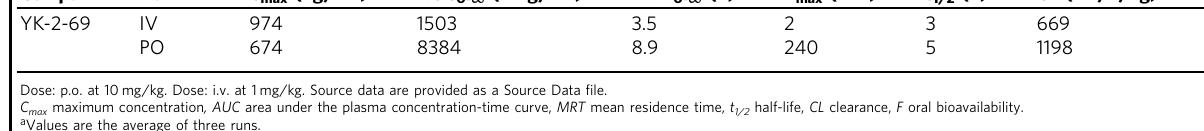
Table 1 Pharmacokinetic parameters of compound YK-2-69 in SD rats a . Compd.